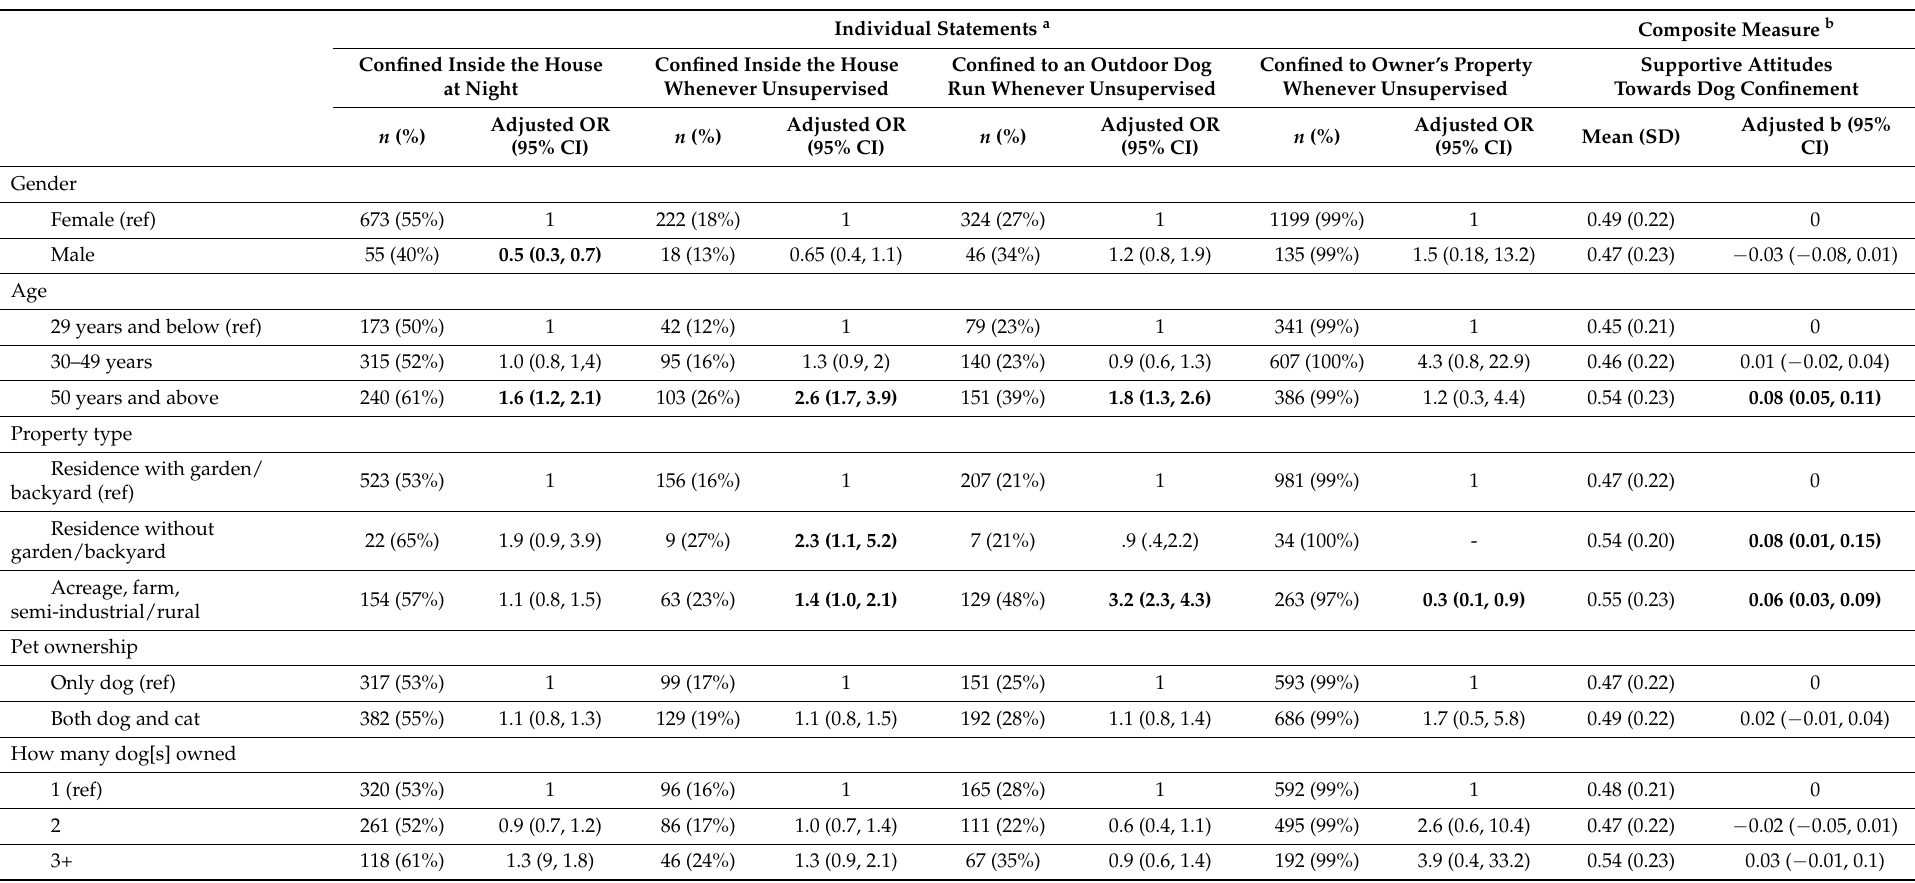
Table 3. Associations between demographic variables and agreement (agree/strongly agree) to statements about dog confinement as well as composite measure “supportive attitudes towards dog confinement” among dog owners ( n =